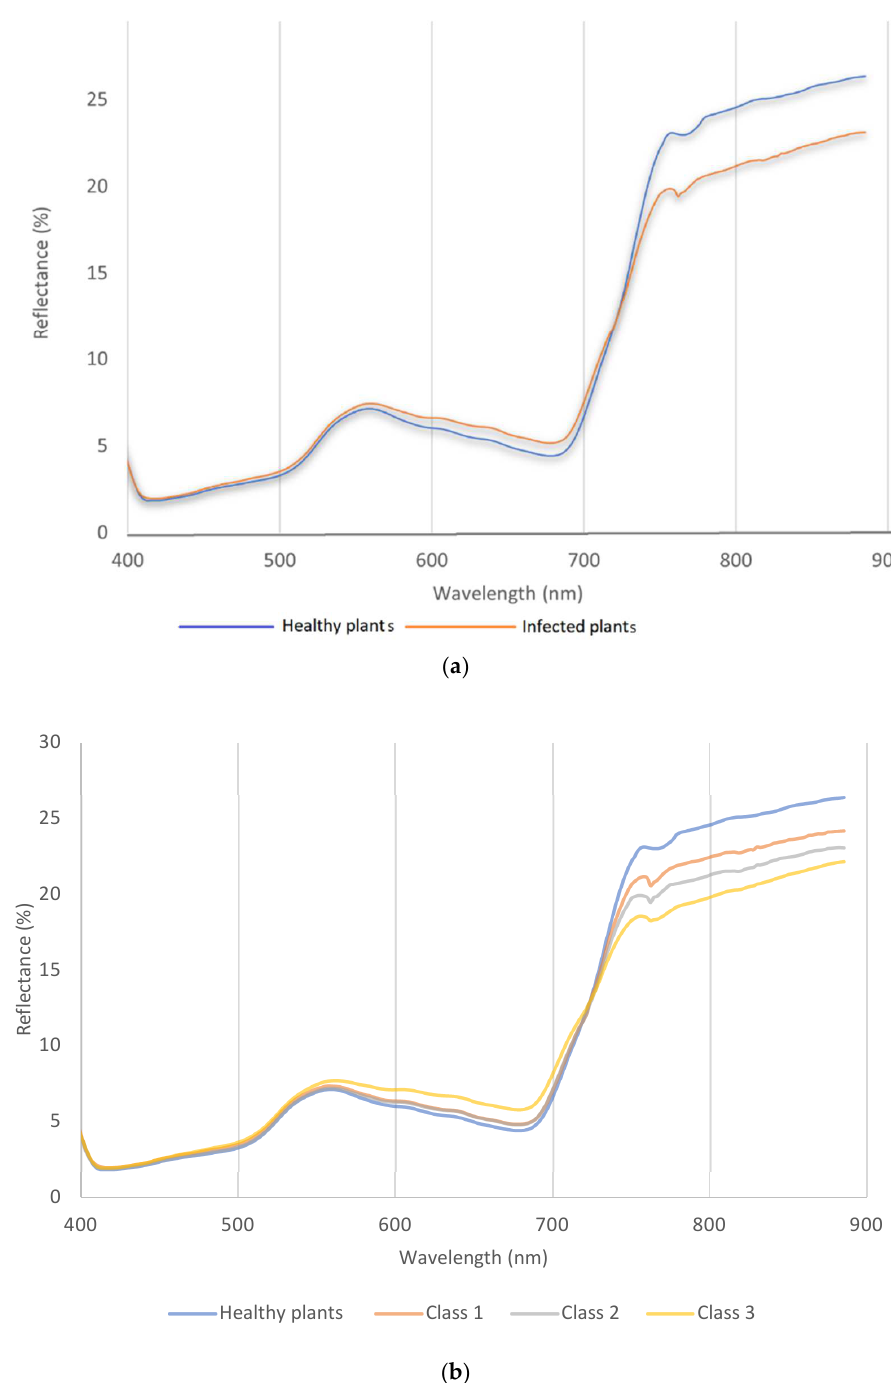
Figure 3. The spectral reflectance curve for wavelength vs. reflectance of wheat plants in stem-rust- inoculated blocks and wheat plants in the fungicide-treated blocks (healthy plants) for ( a ) binary classification and ( b ) multiclass (class 1, 2, and 3).